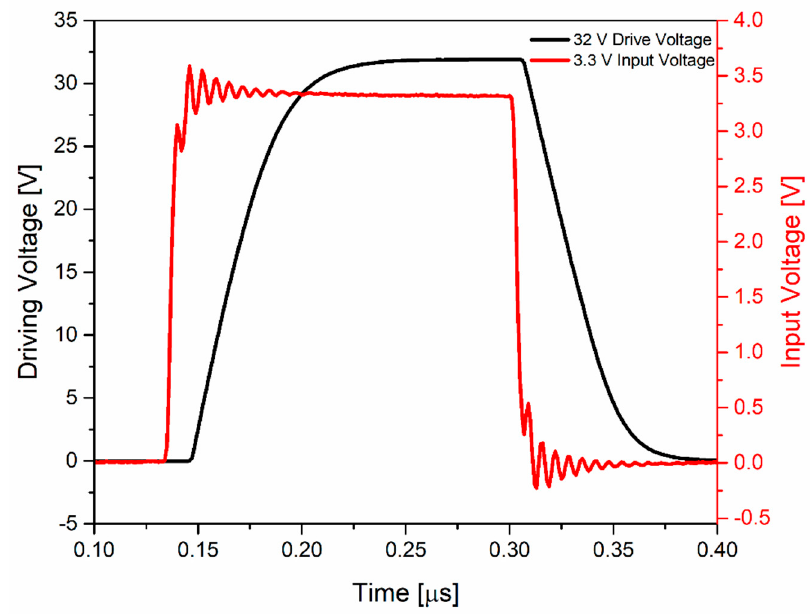
Figure 12. Waveform of the HV transmitter input and output.